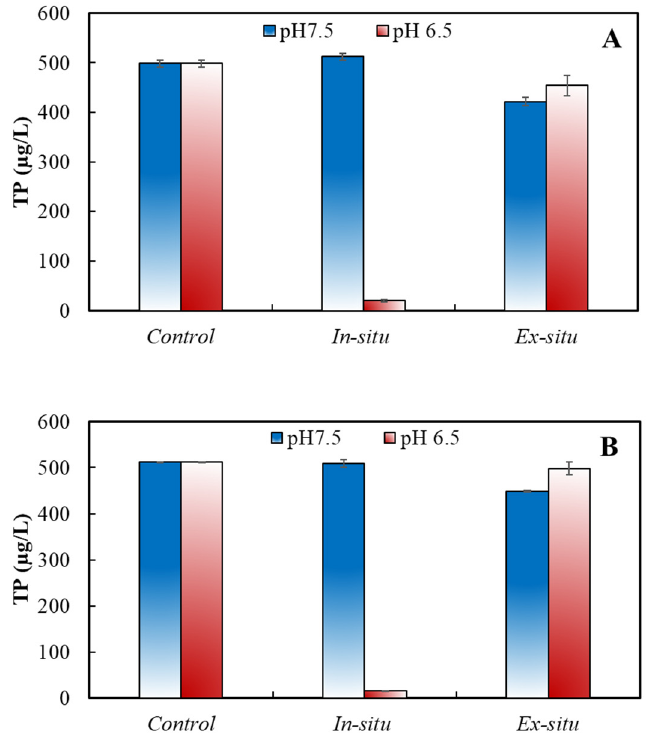
Figure 4. Ferrate (VI) removal of different model DOP compounds at different conditions: ( A ) DNA; ( B ) ATP. (TP = 500 µ g/L as P; Fe (VI) = 5.0 mg/L; pH = 6.5 or 7.5; Control: no ferrate (VI) addition; in-situ treatment: direct ferrate (VI) addition to DOP-containing solution; and ex-situ treatment: ferrate (VI) decay followed by DOP addition).